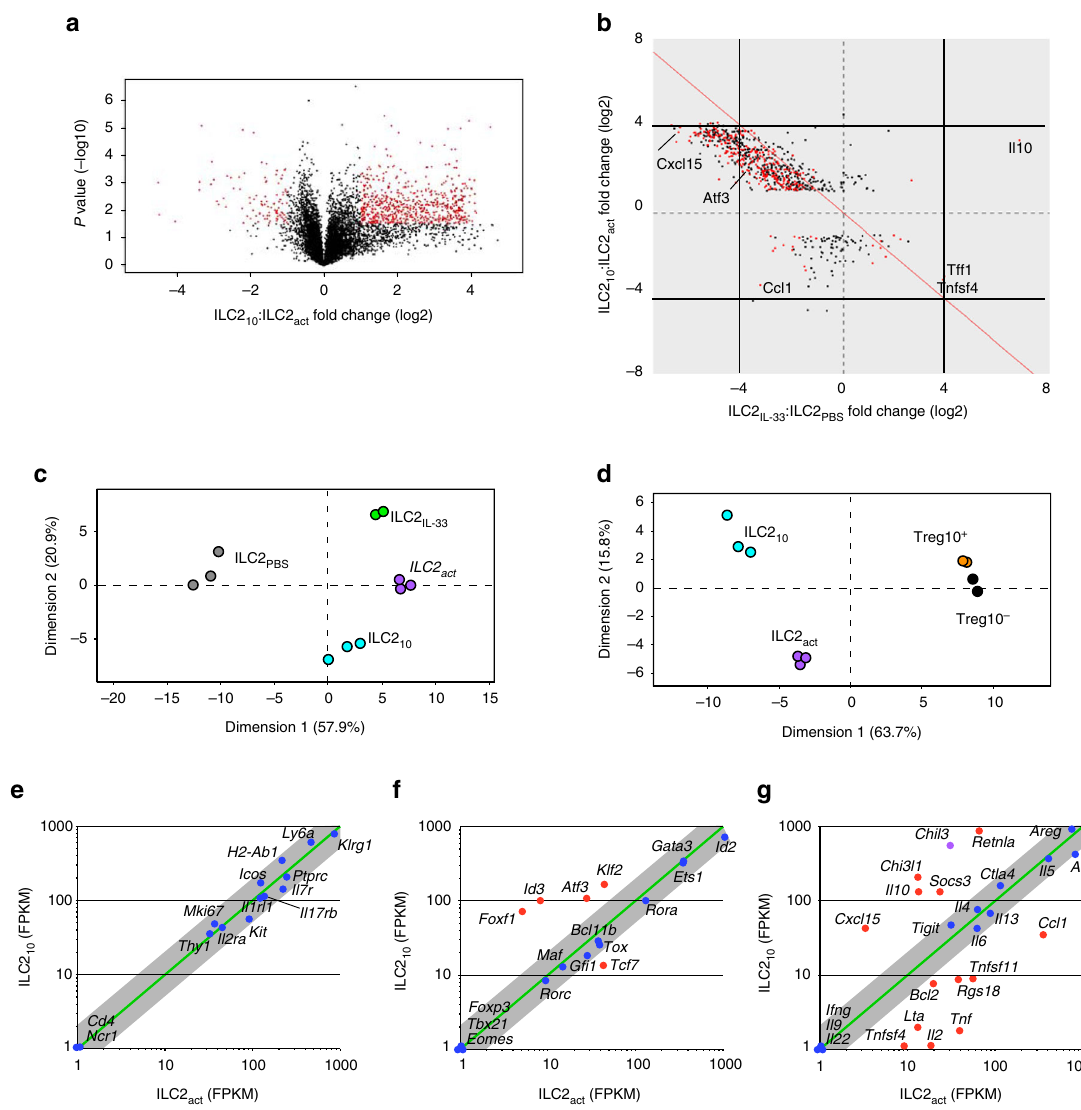
Fig. 3 ILC2 10 represent a molecularly distinct ILC2 activation state. a Volcano plot for differentially expressed genes, de fi ned as in Fig. 1, comparing ILC2 10 and IL-33 activated IL-10 – ILC2 (ILC2 act ). Genes de fi ned as statistically signi fi cant analyzed as in Fig. 1 are shown in red. b Fold-change plot of differentially expressed genes in the intersection of indicated ILC2 populations. Genes de fi ned as statistically signi fi cant in a are shown in red. c Principal component analysis of RNA-seq data from puri fi ed total ILC2 from PBS (ILC2 PBS ) or IL-33 (ILC2 IL-33 ) injected mice, or from isolated ILC2 10 or ILC2 act from IL-33 injected mice. d Principal component analysis of RNA-seq data comparing ILC2 10 and ILC2 act , with IL-10 + and IL-10 – T reg cells . e – g Selected genes plotted as the average FPKM from ILC2 10 vs. ILC2 act , presented as in Fig. 1. Shown are expression of selected genes grouped by ( e ) ILC2 markers and markers of activation, ( f ) transcription factors, and ( g ) effector molecules ( Chil3 , purple, P = 0.05). Data are from two or three independent experiments with fi ve